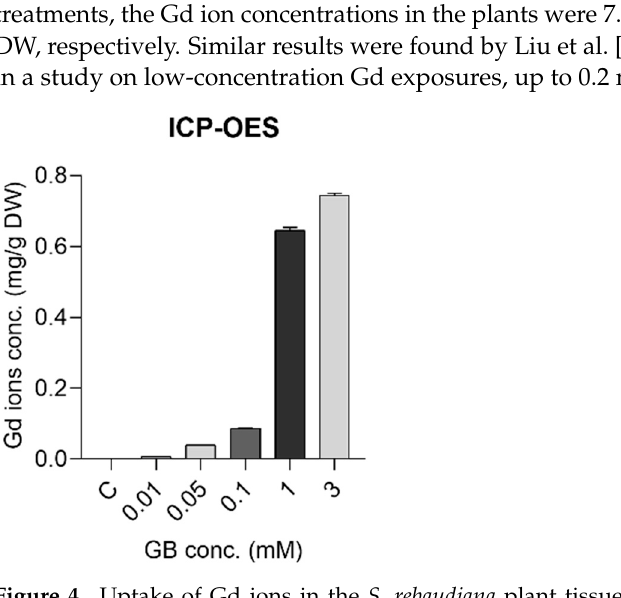
Figure 4. Uptake of Gd ions in the S. rebaudiana plant tissues exposed to GB in concentrations 0–3 mM, quantified by ICP-OES. The results are presented as mean and SD.